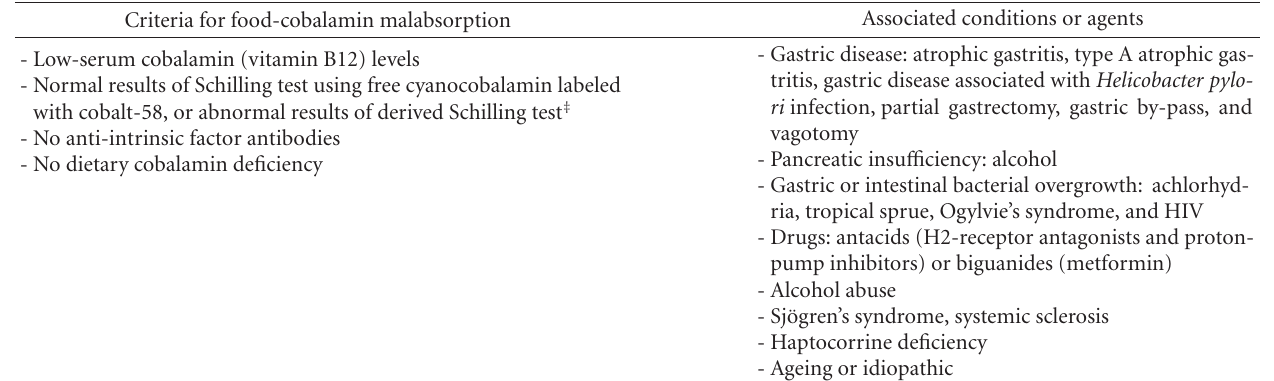
Table 3: Food-cobalamin malabsorption syndrome [4, 14,